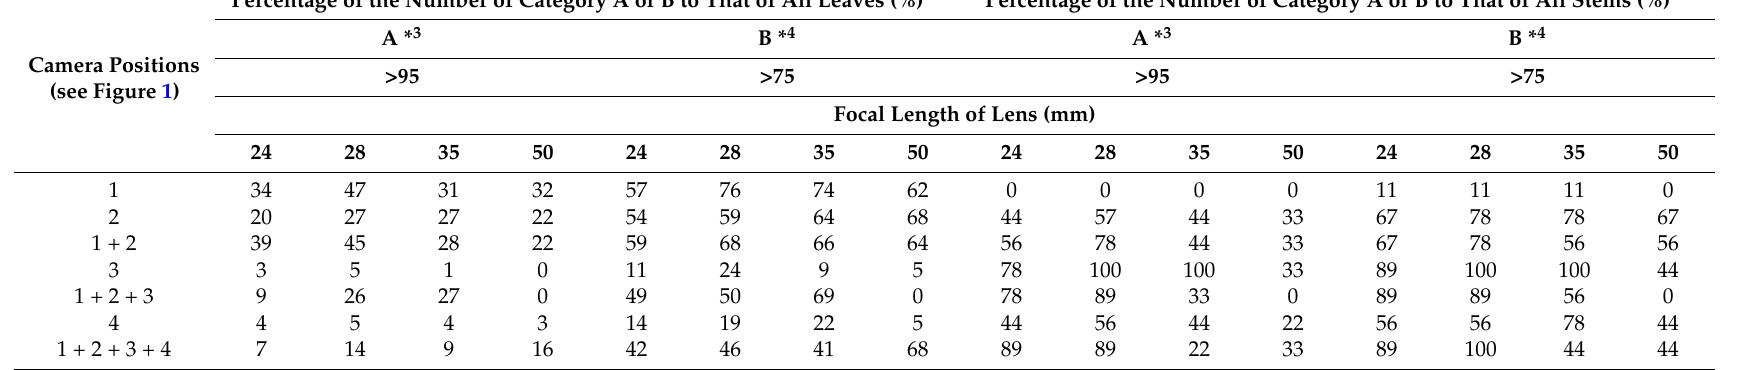
Table 2. Percentage of the total number of virtual leaves and stems whose 3D model shape surface area reconstructed over 95% (Category A) or 75% (Category B) accounting for the total number of real leaves and